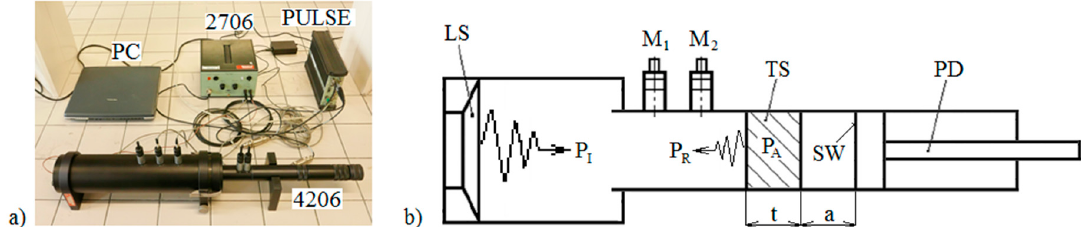
Figure 2. View of the experimental setup for measuring frequency dependencies of the sound absorption coefficient ( a ) and a scheme of the two-microphone acoustic impedance tube ( b ). Legend